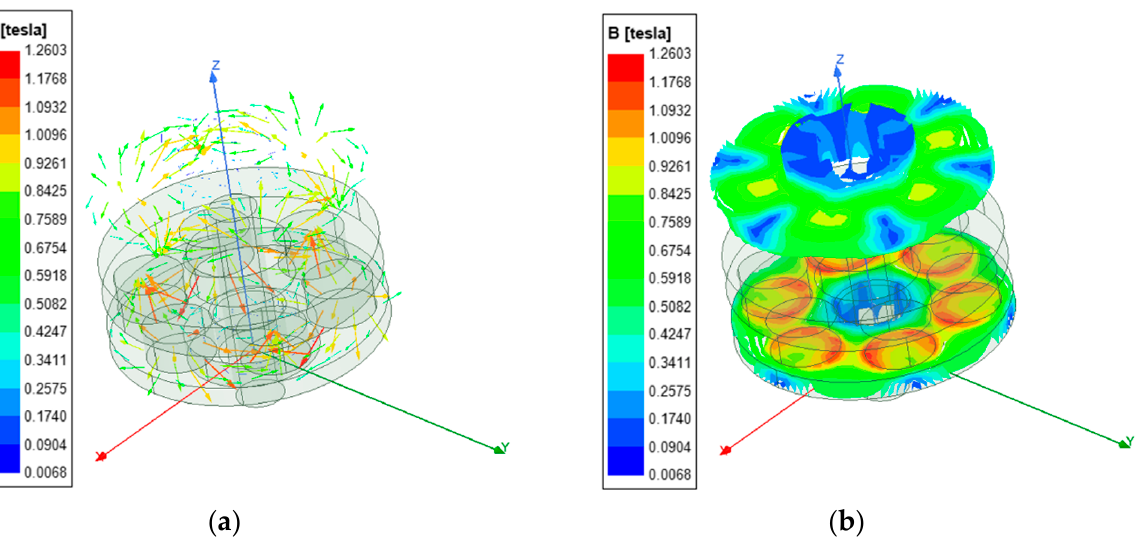
Figure 11. Static magnetic flux density distribution of the rotor disks: ( a ) Vector distribution; ( b ) Field distribution.